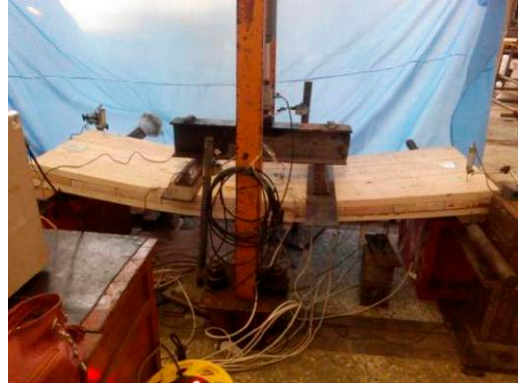
Figure 8. Full view of specimen deformation.